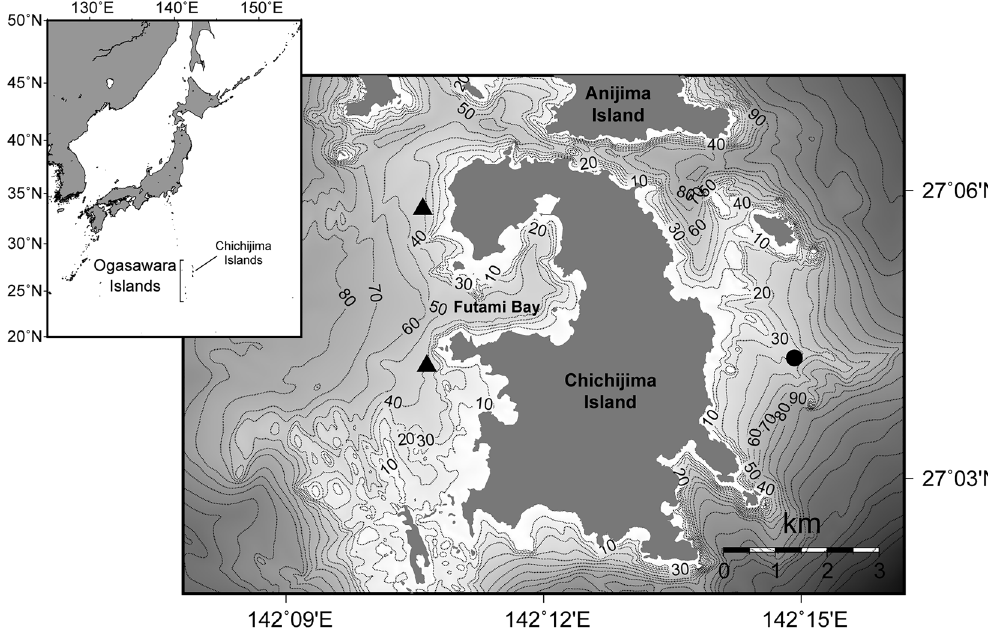
Figure 1. Maps of the study sites, Chichijima Island, Ogasawara, Japan. Black triangles ( ▲ ) and a black circle ( ● ) indicate the mooring stations of the AUSOMS-mini stereo and the AUSOMS ver. 3.5, respectively. The bathymetry data was based on the M7023 digital bathymetry chart provided by the Japan Hydrographic Association. The figure was created using GMT (Generic Mapping Tools) version 5.4.3 (https:// www. gener ic- mappi ng- tools. org/) 32